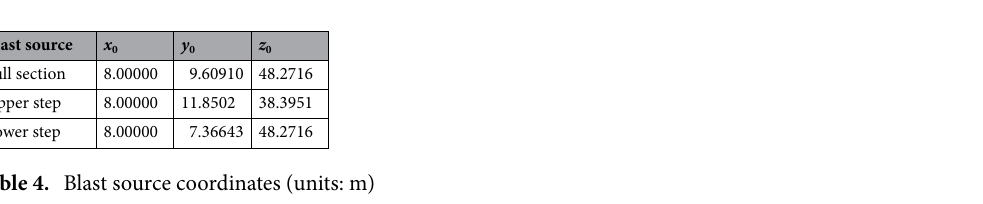
Table 4. Blast source coordinates (units: